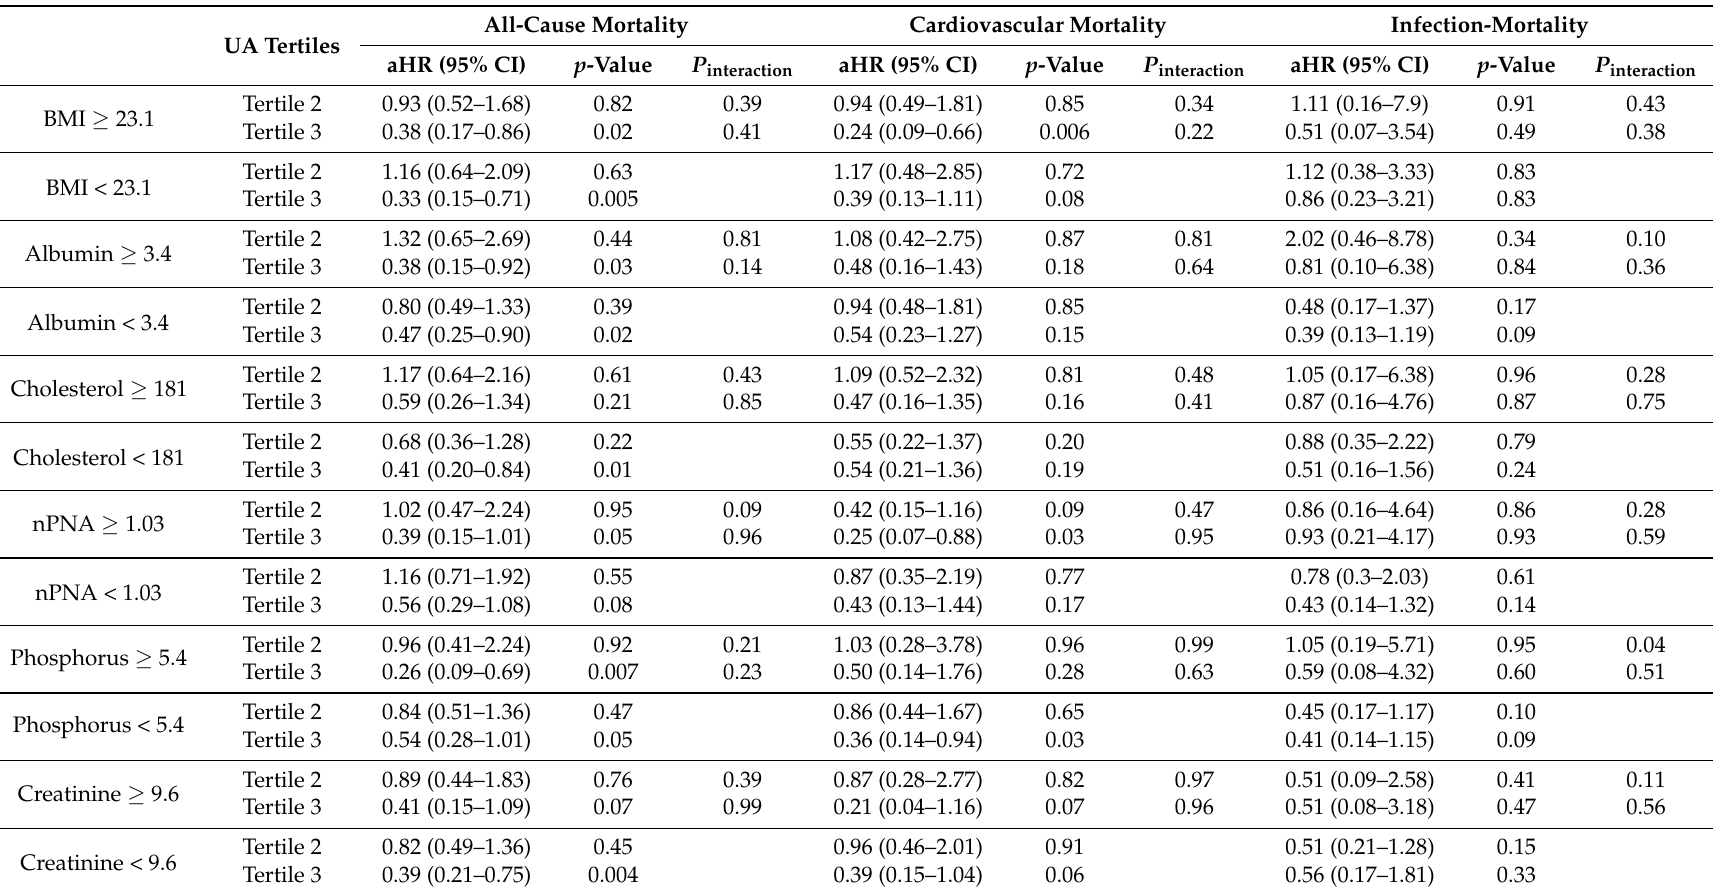
Table 6. Stratified analyses by various nutritional